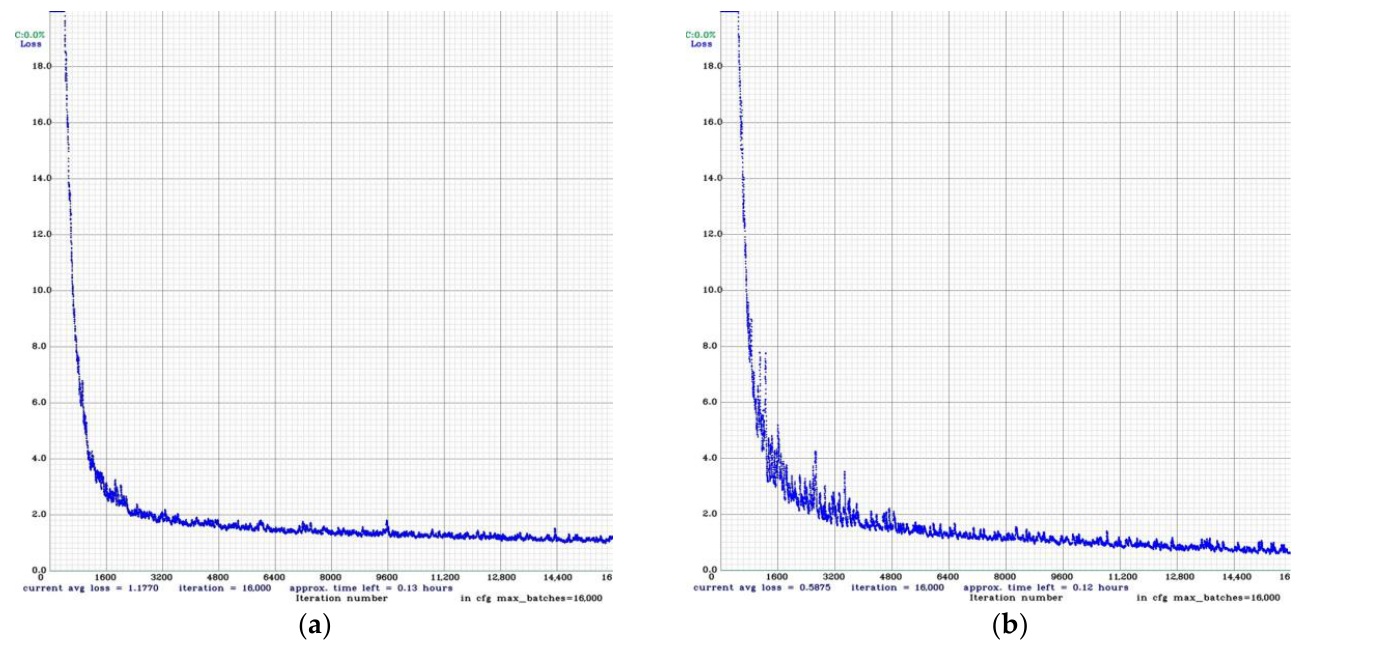
Figure 12. The object recognition procedure of the AI recognition models.